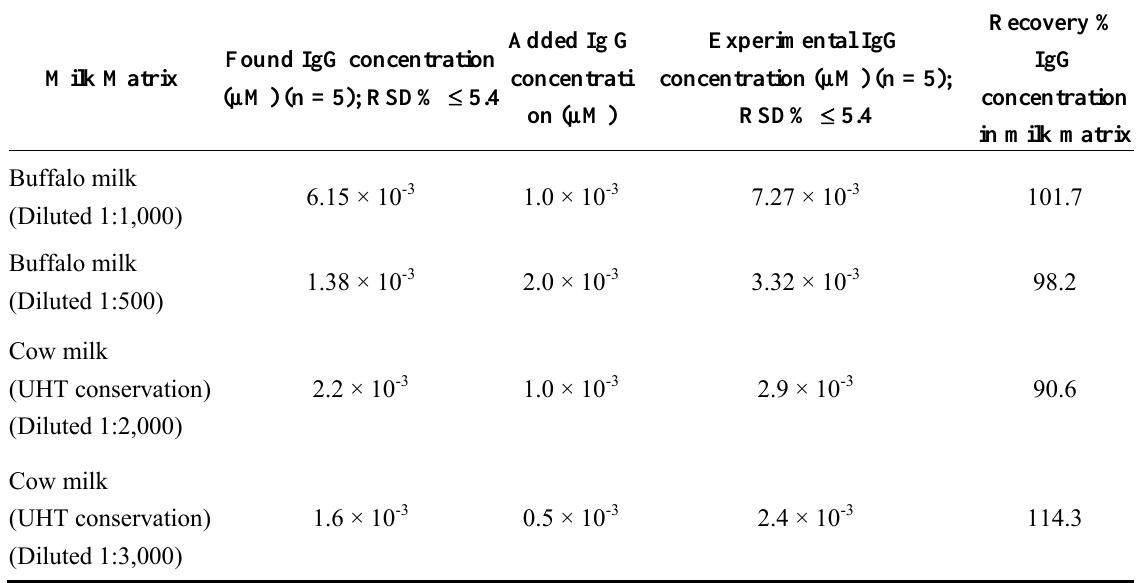
Table 4. Recovery tests of added IgG in cow and buffalo milk using the standard addition method.